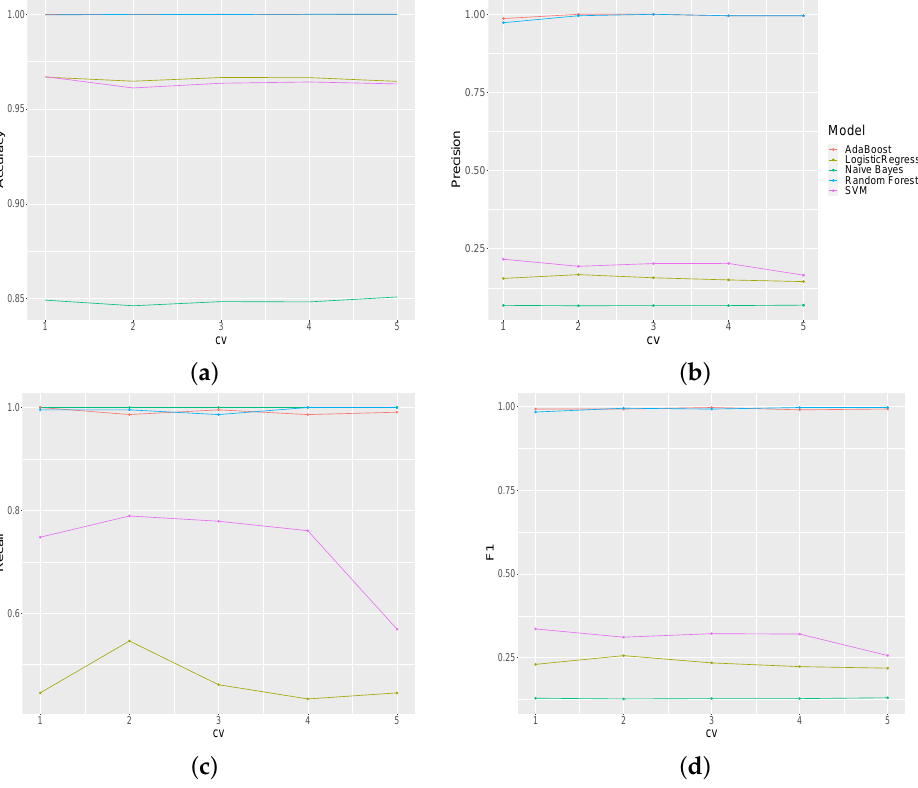
Figure 7. Metrics by iteration: ( a ) Accuracy. ( b ) Precision. ( c ) Recall. ( d ) F1. Table 6. Best score model by